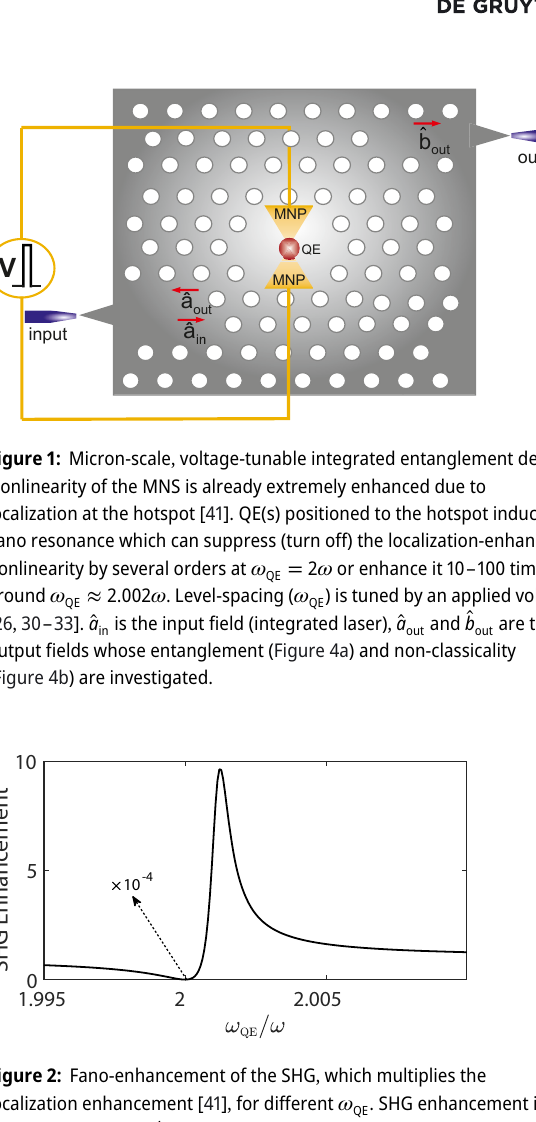
. SHG enhancement is QE via QE